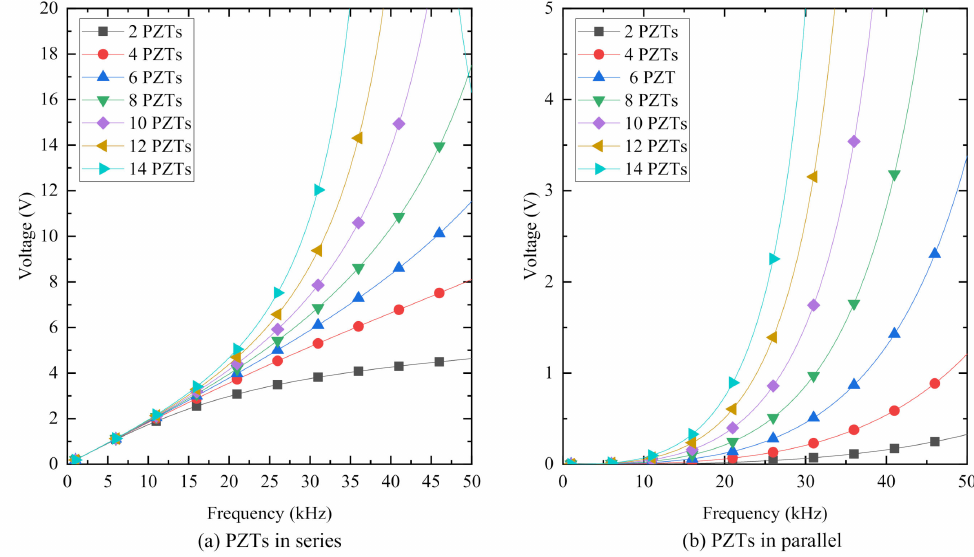
Figure 10. The output voltage of PiSSAs with a resistor R = 10 k Ω versus the frequency of the excitation load: ( a ) PZTs in series connection; and ( b ) PZTs in parallel